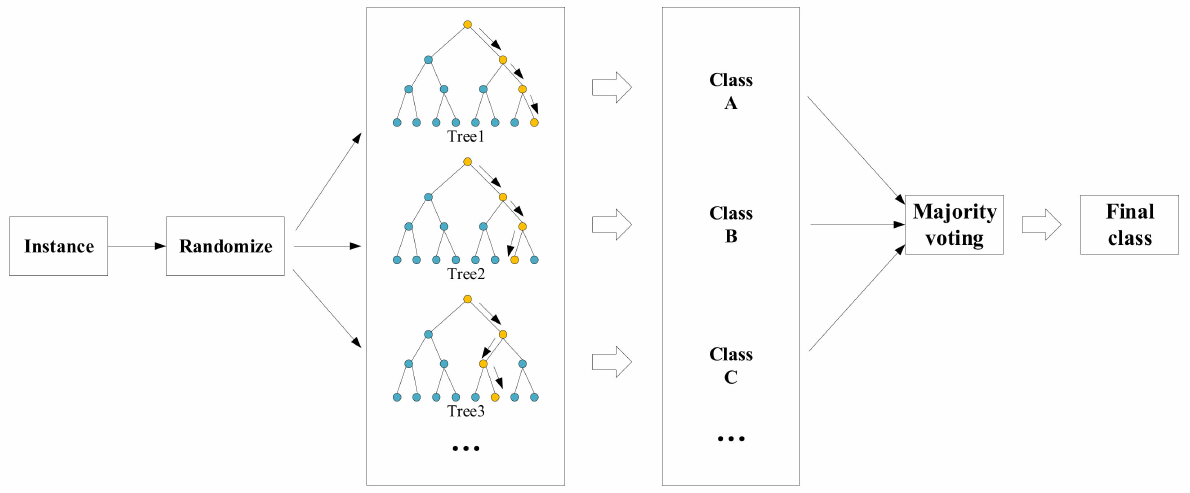
Figure 1. Random-forest construction